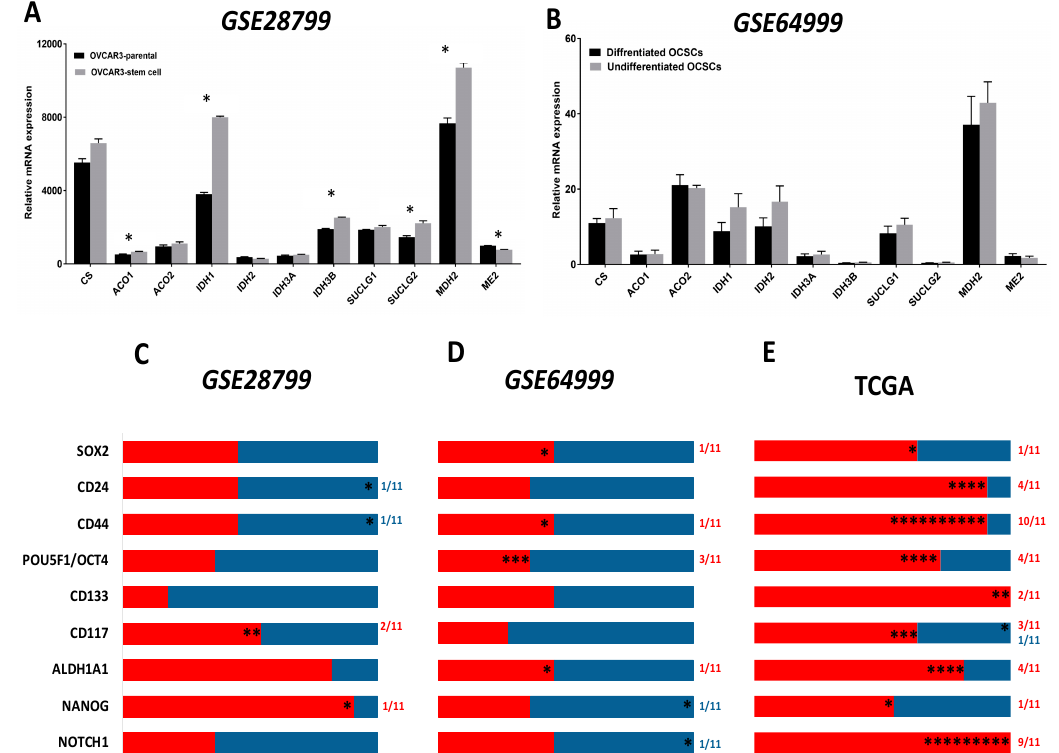
Figure 4. Expression of TCA markers in OCSC models. ( A , B ) Bars represent mean ± SEM of the relative mRNA expression of the indicated TCA enzymes in OVCAR3 stem-cells vs. their parental cells in GSE28799 and undi ff erentiated vs. di ff erentiated OCSCs in GSE64999. Significance was determined using the multiple t -test and Holm–Sidak method with each row analyzed individually with p < 0.05, without assuming a consistent SD. ( C – E ) Bar graphs represent the prevalence of positive ( red ) and negative ( blue ) correlations of the indicated OCSC markers and TCA enzymes in Supplement Tables S3–S4 and Table 2. * indicate the number of significant correlations either positive or